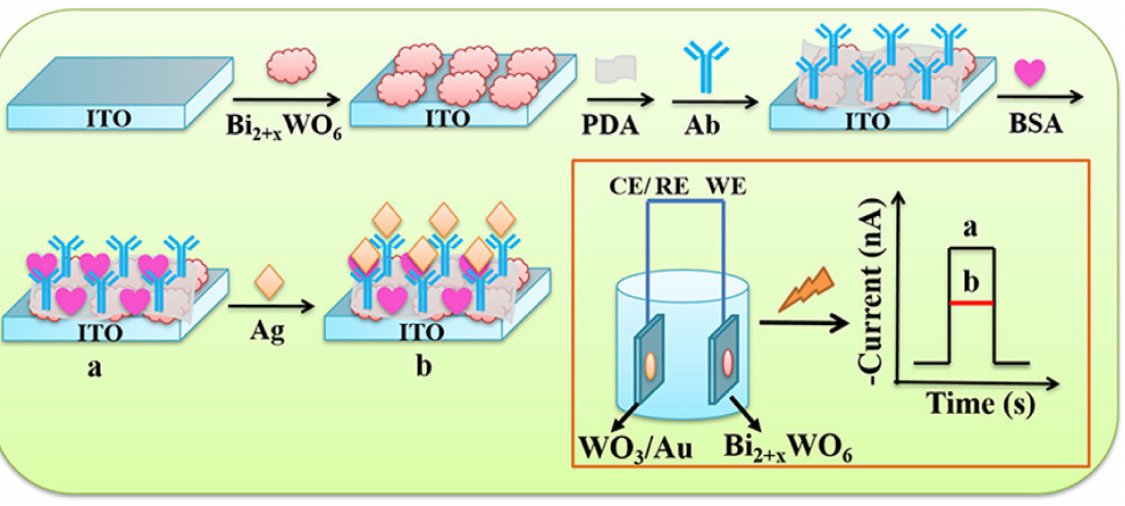
Figure 27. Procedure for the fabrication of Photocathode–Based Immunosensor ITO/Bi 2+x WO 6